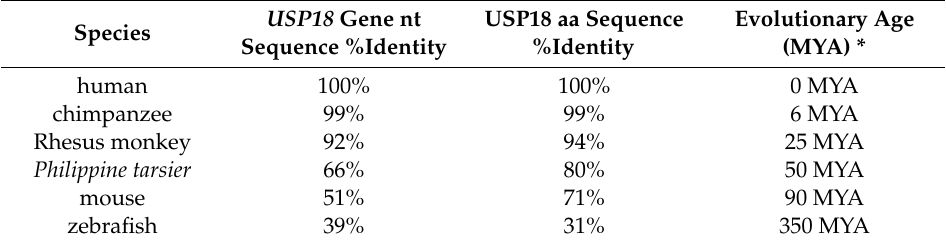
Table 2. USP18 gene and protein sequence identities and evolutionary time between species.